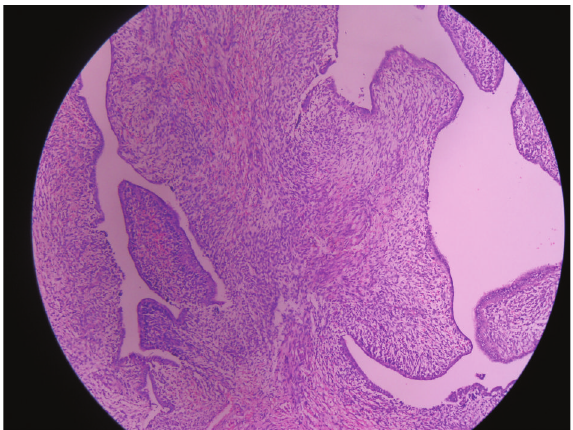
Figure 4: Photomicrograph (H&E stain: original magnification × 10) showing the papillary growth lined by cuboidal epithelium projects from the surface and into the cystic spaces. The subepithe- lium has scattered glands with surrounding stroma composed of